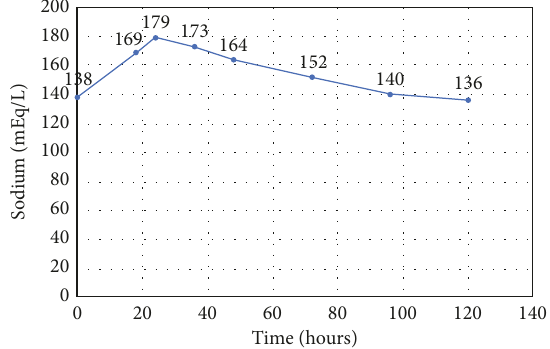
Figure 3: Time course of sodium